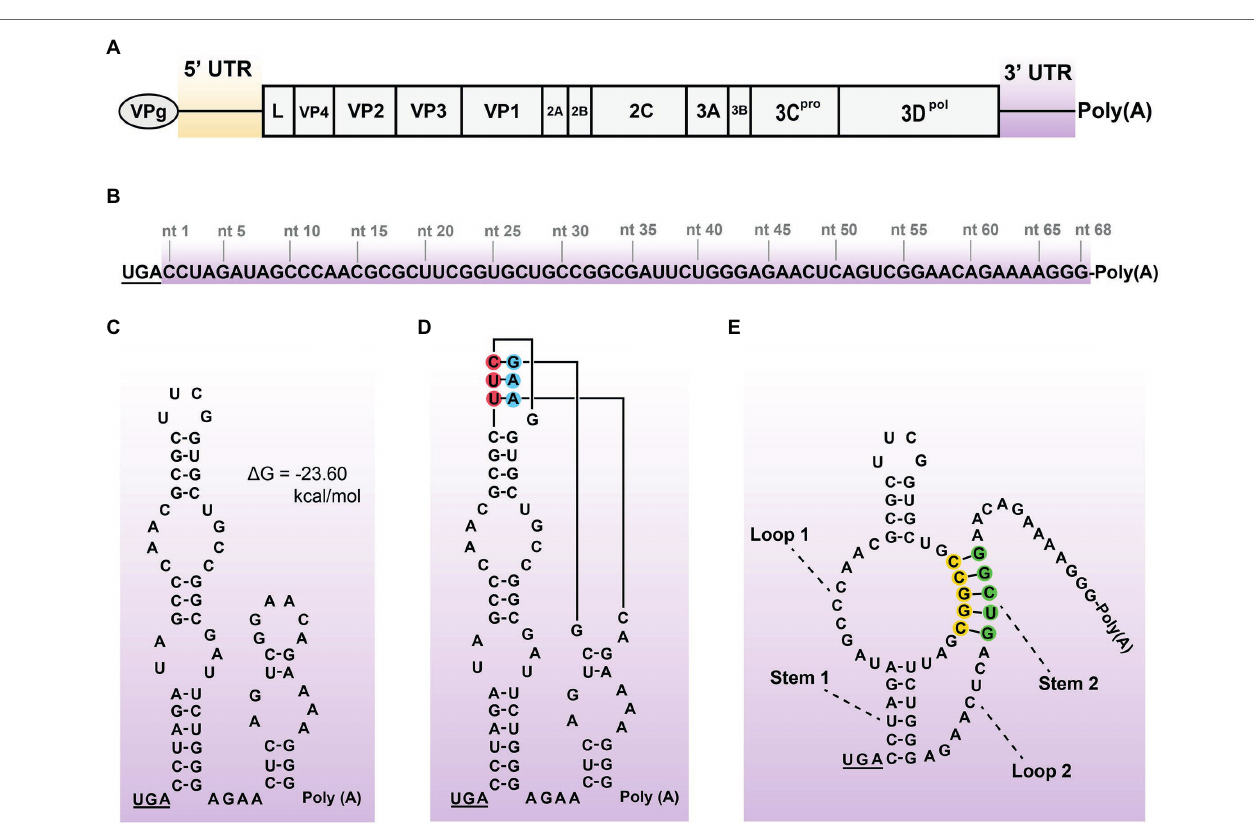
FIGURE 1 | Schematic representations of SVA genome, 3’ UTR sequence, and its potential structures. Positive-sense, single-stranded, and linear SVA genome (A) . A typical genome is composed of 5’ UTR, polyprotein ORF, 3’ UTR, and poly(A) tail. The VPg is covalently linked to the 5 ′ end of genome. The proportion of elements does not exactly match them in the genome. 68-nt-long sequence of 3’ UTR (B) . Putative secondary structure of 3 ′ UTR (C) . The 3 ′ - UTR sequence is analyzed using the UNAFold Web Server (http://www.unafold.org/) for modeling its RNA secondary structure, which contains two adjacent stem-loops. The stop codon (UGA) is underlined. Two terminal loops are predicted to have a potential “kissing interaction” with each other by means of a triple base-pairing pattern ( D , red/blue circle-marked). Such an interaction refers to that of the SVV-001 strain (Hales et al., 2008). H-type-like pseudoknot (E) , composed of two stems (Stem 1 and 2) and two loops (Loop 1 and 2), is predicted in 3’ UTR by the DotKnot web server. The Stem 2 contains two PFMs, separately marked with yellow and green